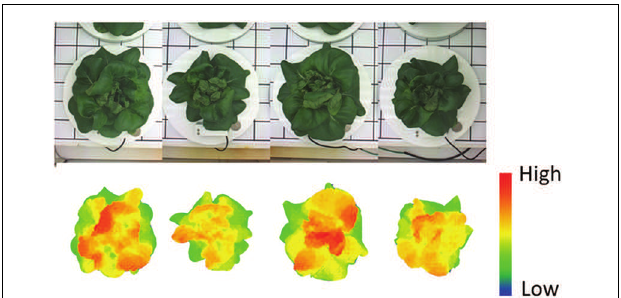
FIGURE 7 | The (top) is the raw image of Boston lettuces and the (bottom) is the corresponding pseudo-color depth image calculated by stereo-vision algorithm.